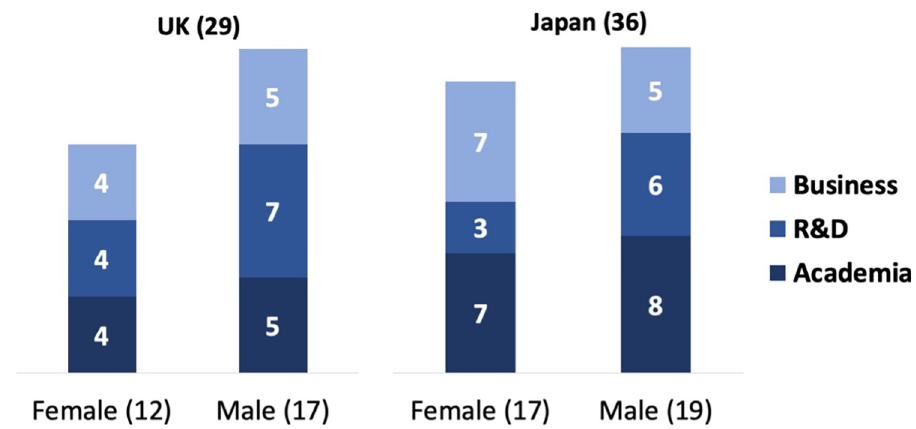
Fig 1. Participating experts by country, gender, and professional